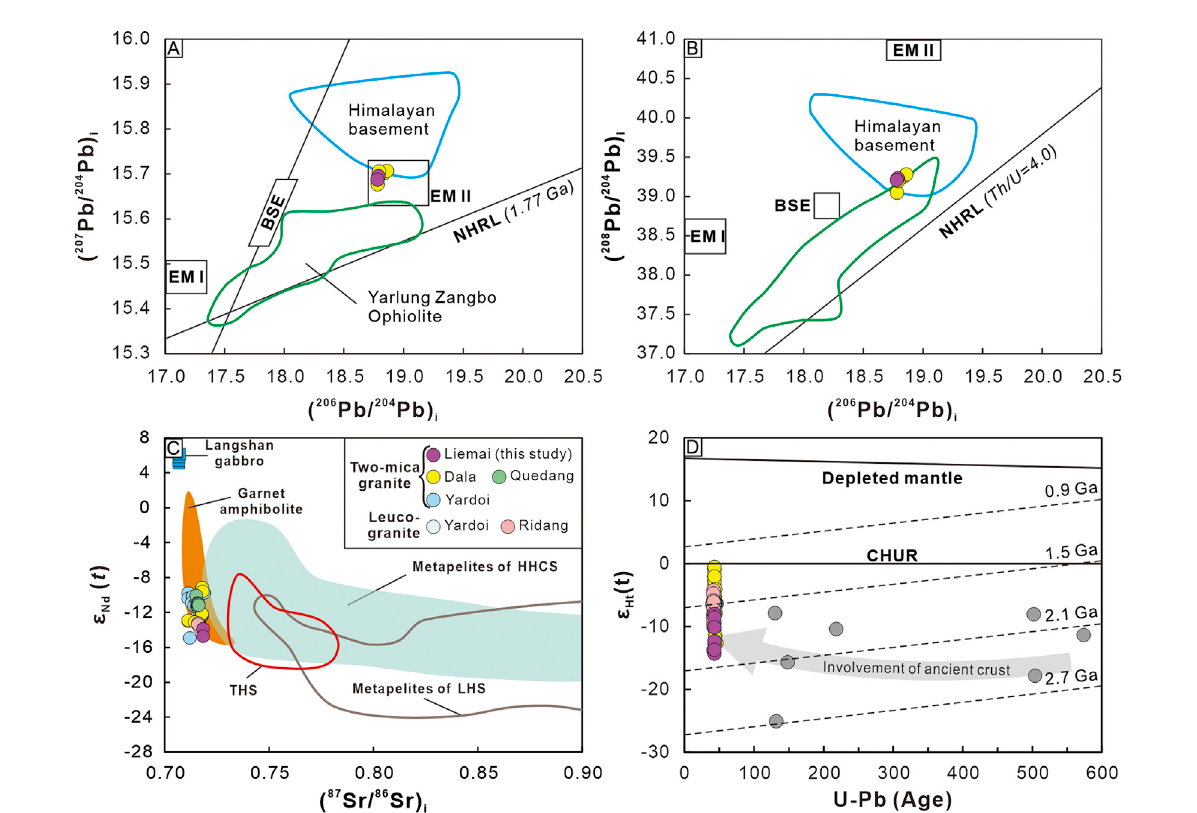
FIGURE 7 (A) ( 207 Pb/ 204 Pb) i vs. ( 206 Pb/ 204 Pb) i , (B) ( 208 Pb/ 204 Pb) i vs. ( 206 Pb/ 204 Pb) i , (C) ε Nd (t) vs. ( 87 Sr/ 86 Sr) i , and (D) ε Hf (t) vs. U-Pb age diagrams for the Liemai two-mica granite. Data source: the Himalayan basement is from Vidal et al. (1982) and Harrison et al. (1999); the Yarlung Zangbo Ophiolite are from Xu and Castillo (2004), Zhang et al. (2005) and Niu et al. (2006); the Bulk Silicate Earth (BSE) and enriched mantle components (EM I and EM II) are from Zindler and Hart (1986); the Langshan gabbro is from Ji et al. (2016); the garnet amphibolite is from Zeng et al. (2011); the metapelites of HHCS are from Inger and Harris (1993), Yang and Jin (2001), Richards et al. (2005) and Zeng et al. (2009, 2012); the LHS and THS are from Richards etal.(2005);thegranites/leucogranitesarethesameasinFigure5.NorthernHemisphereReferenceLine(NHRL): 207 Pb/ 204 Pb=0.1084× 206 Pb/ 204